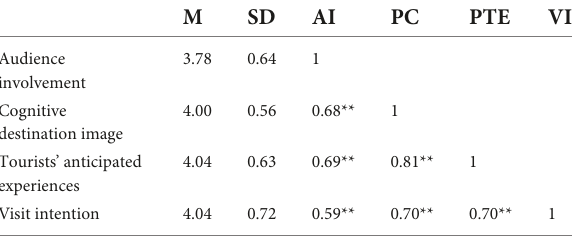
TABLE 2 Descriptive statistics and correlation analysis results of each research variable ( N =